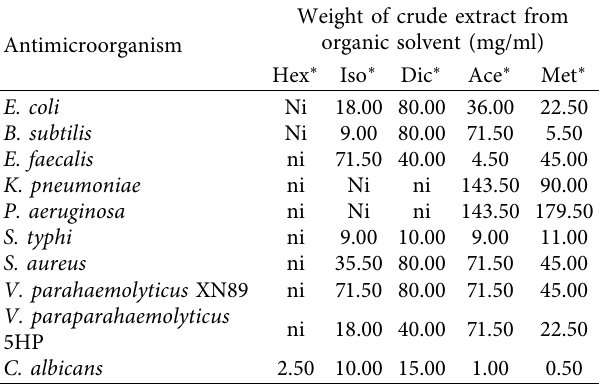
Table 3: Minimum inhibitory concentration (MIC) of crude ex- tract by microdilution assay.